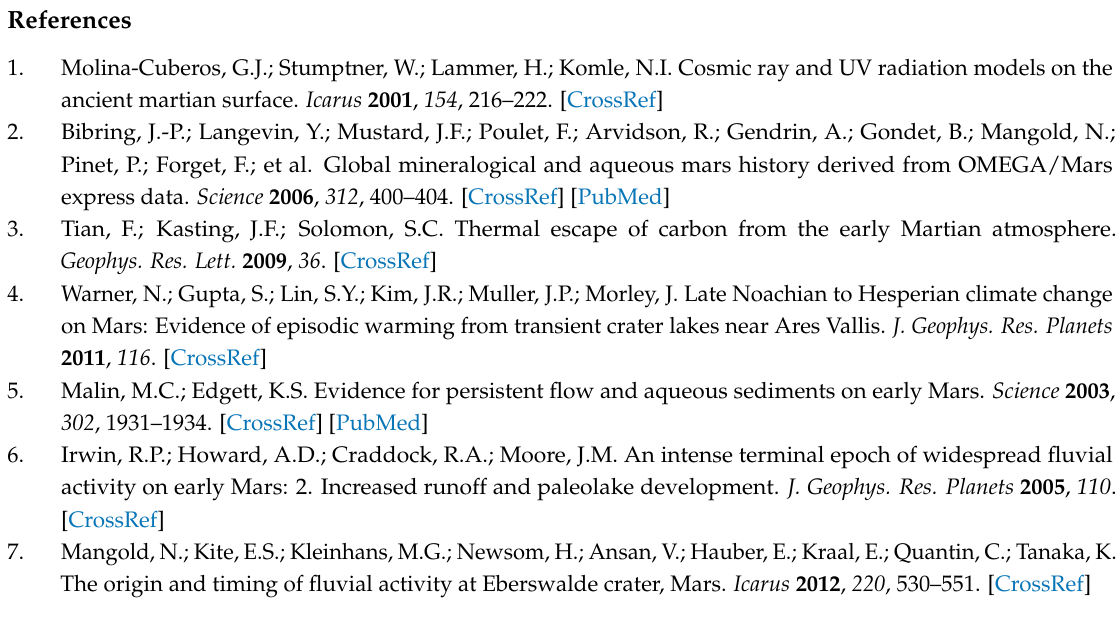
Table S1: Taxonomic classification of the tRFs assigned by in-silico digestion of the MiSeq data. Author Contributions: Conceptualization, E.C.-H., S.P.S., V.K.P. and K.O.-F.; Methodology, E.C.-H. and S.S.; Resources, K.O.-F.; Data Curation.; Writing-Original Draft Preparation, E.C.-H. and K.O.-F.;